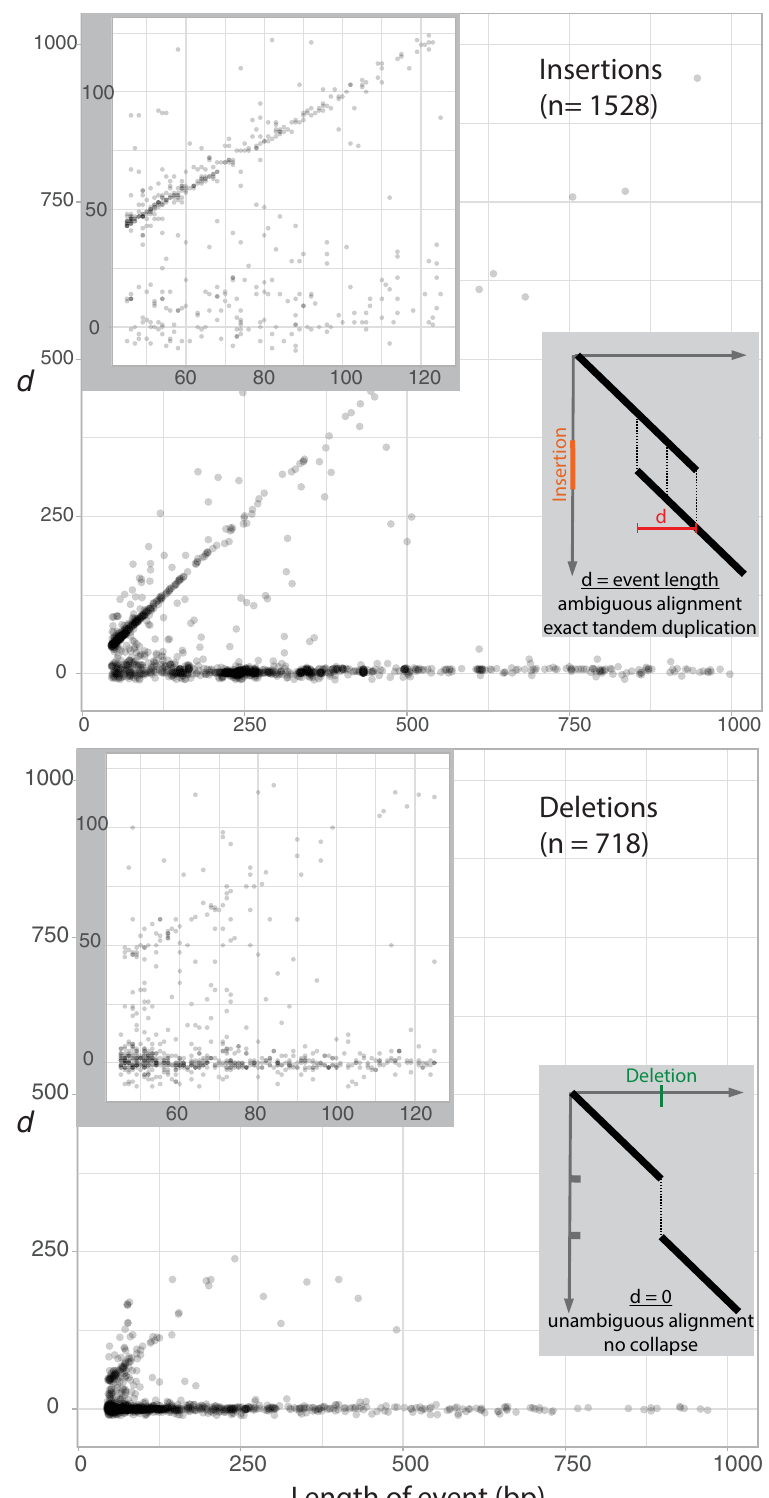
Fig 2. Tandem bias in insertions versus deletions between Nipponbare and CarGold. Indel size is plotted against the d metric for each insertion and deletion satisfying our alignment and inference criteria. Upper corner insets